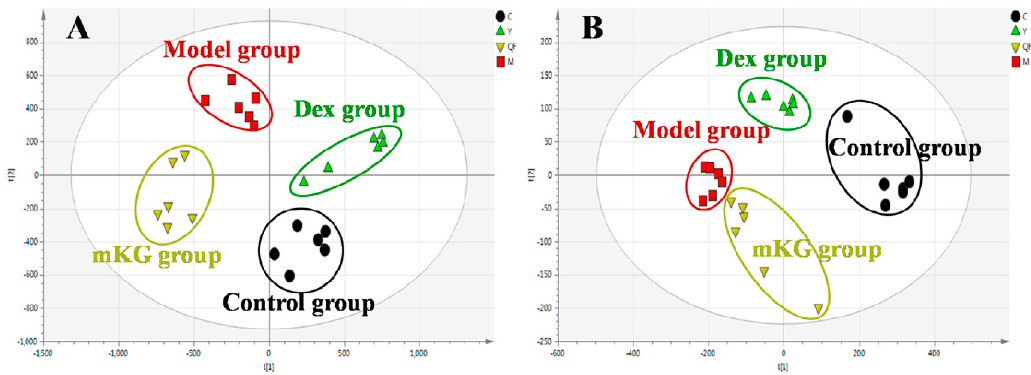
Figure 3. Score plots from the PLS − DA model classifying the control group ( ● ), model group ( ■ ), mKG group ( ▼ ), and Dex group ( ▲ ) with mice lung tissue samples in positive ( A ) and negative ( B ) ion modes by UPLC-Q-TOF/MS.